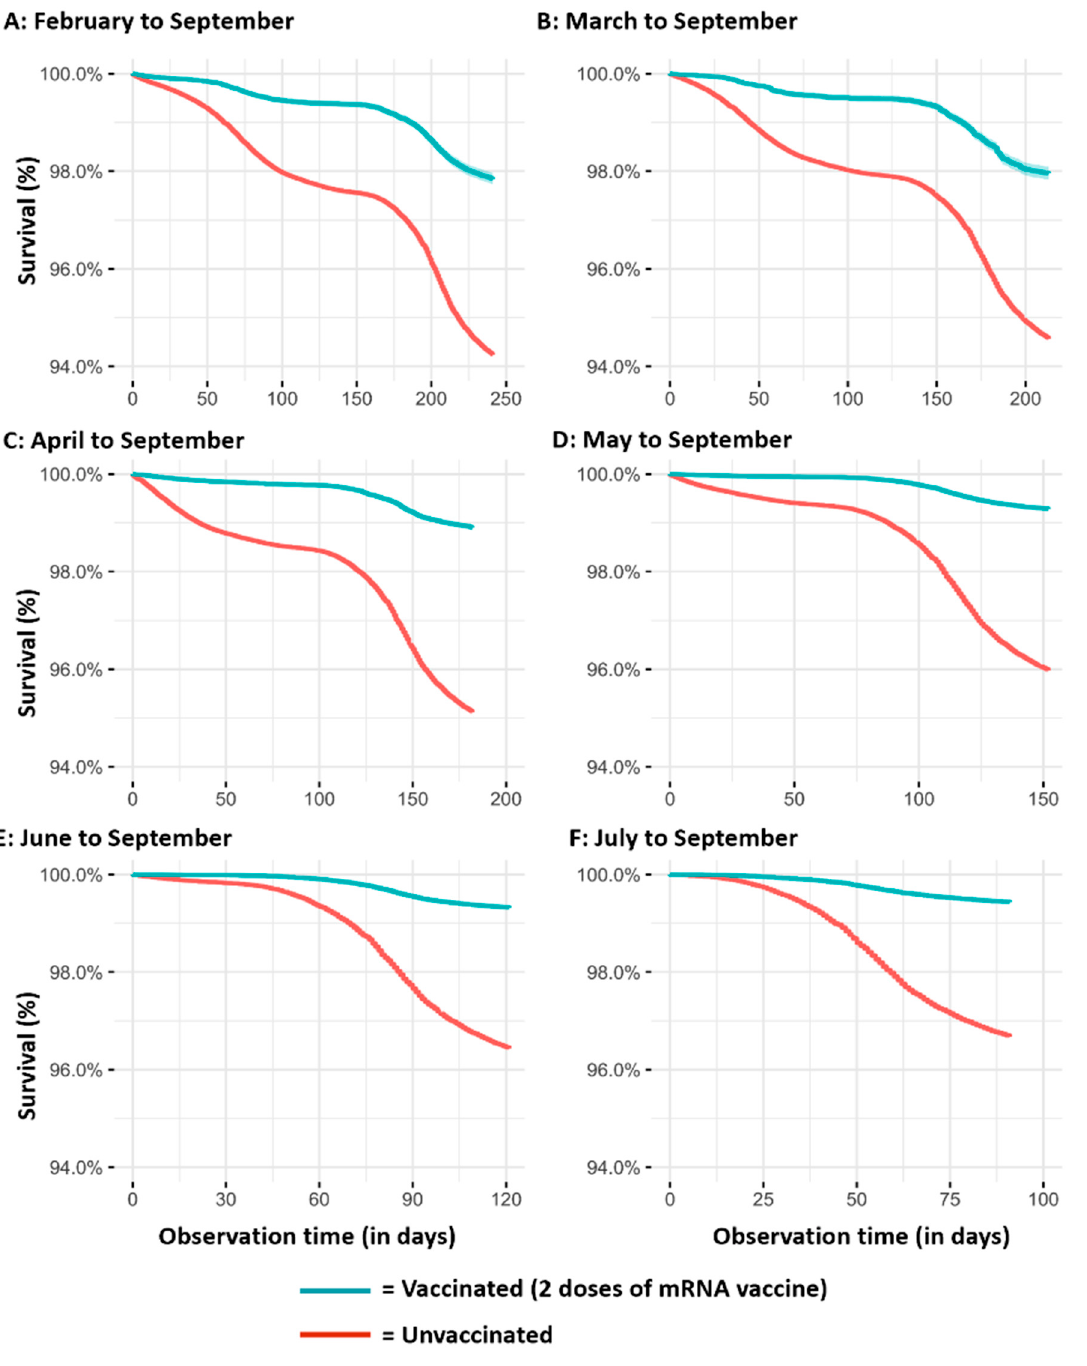
Figure 1. Kaplan–Meier survival analyses on SARS-CoV-2 infection over time in vaccinated and unvaccinated subjects according to the different observation periods (( A ): February to September; ( B ) March to September; ( C ) April to September; ( D ) Mayto September; ( E ) June to September; ( F ): July to September).